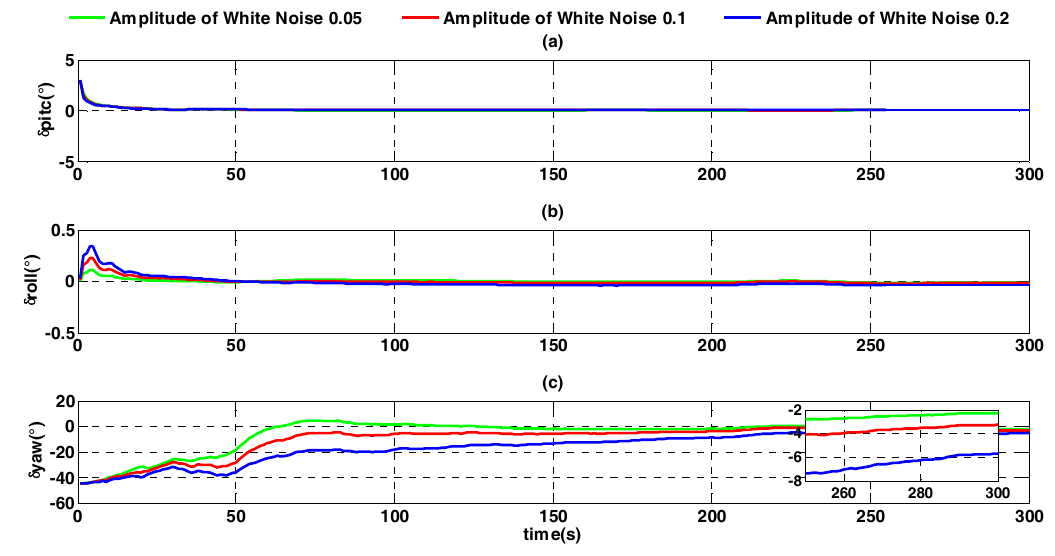
13 of 16 Figure 11. Alignment error curves of different constant errors. ( a ) The error curves of pitch angle; ( b ) the error curves of roll angle; ( c ) the error curves of heading angle. In Figure 11, it can be seen that, under conditions of different constant error of velocity, horizontal attitude error can converge fast, while the error of the heading angle increases with the increasing of constant error. The heading angle errors are similar when constant errors are 0.1m/s and 1 m/s, at which point the heading angle errors are − 1.787° and − 1.807°. In comparison, the heading angle error is − 2.099° when constant error is 2m/s. The constant error of external reference velocity influences the alignment accuracy in accordance with the term of acceleration b b ib × ω v , but its influence is limited.